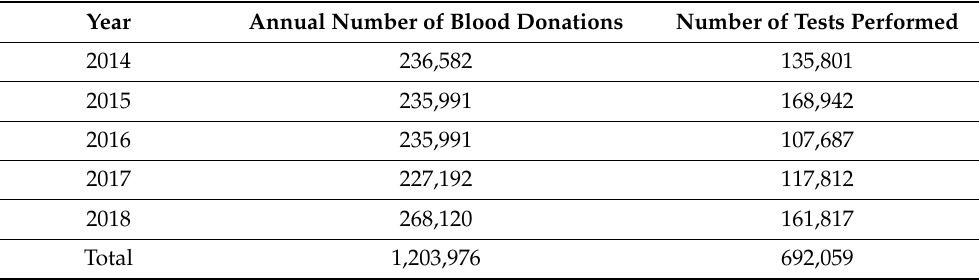
Table 3. Annual blood donations and NAT performed in Lombardy between 2014 and 2018.